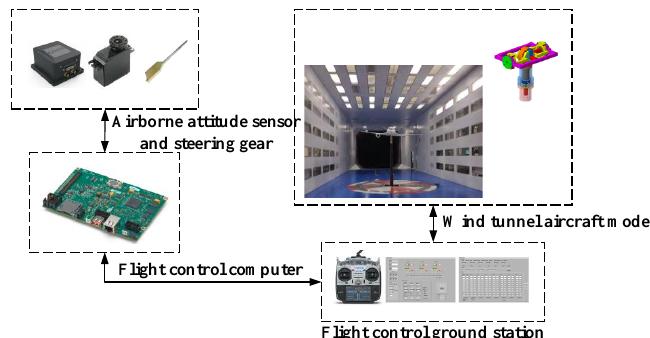
Figure 13. Flight control and measurement system.